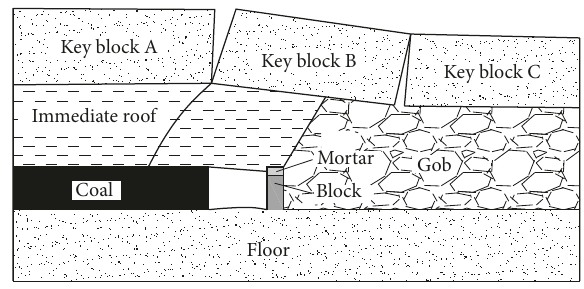
Figure 7: Diagram of the surrounding rock structure of gob-side entry retaining when a pressure-releasing support wall is used.